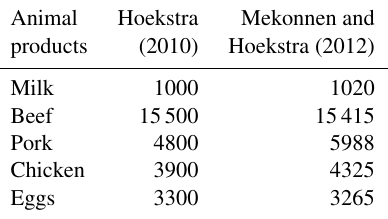
Table 12. Water footprint (Lkg − 1 ) of animal products in various